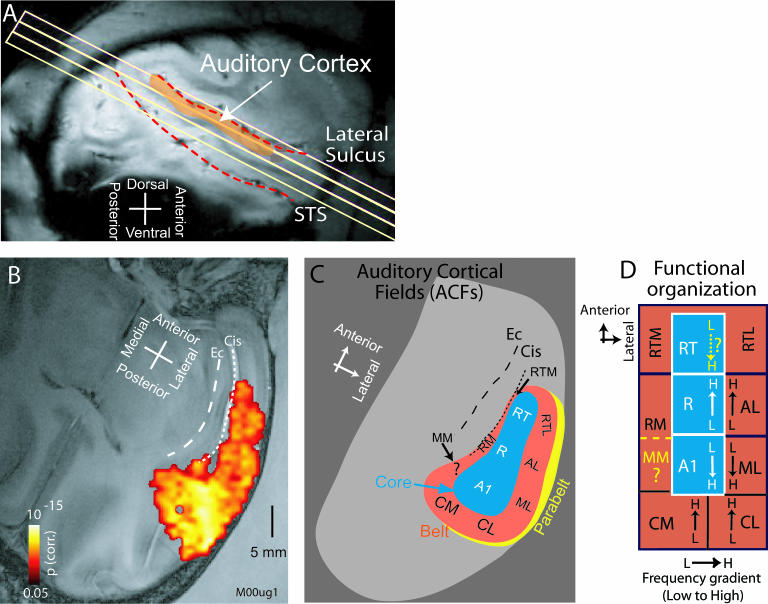
Macaque fMR Imaging and ACFs(A) Imaging slices were aligned with the lateral sulcus to obtain a plane of auditory cortex activity on the lower bank of this sulcus (colored in translucent orange; STS, superior temporal sulcus). (B) Shows activations to broadband noise from one anesthetized animal. (C) Schematizes the possible ACFs contributing to activity in (B) [
1,
3,
16–
21]. (D) Schematizes functional properties of ACFs that could distinguish them. Two of the three core or primary ACFs (blue) have frequency selective gradients, shown with arrows from low (L) to high (H) frequency selectivity. The question mark in the core field RT indicates limited evidence of such a gradient in primates [
2]. Anatomy suggests there could be seven or eight belt or non-primary ACFs (orange) [
1,
3]. Only four of the belt ACFs have neurophysiologically described frequency gradients, and these fields are considered to be less responsive to single-frequency tones, preferring instead more complex sounds [
16,
18,
19,
21,
28,
29]. Abbreviations: Ec, external capsule; Cis, circular sulcus.